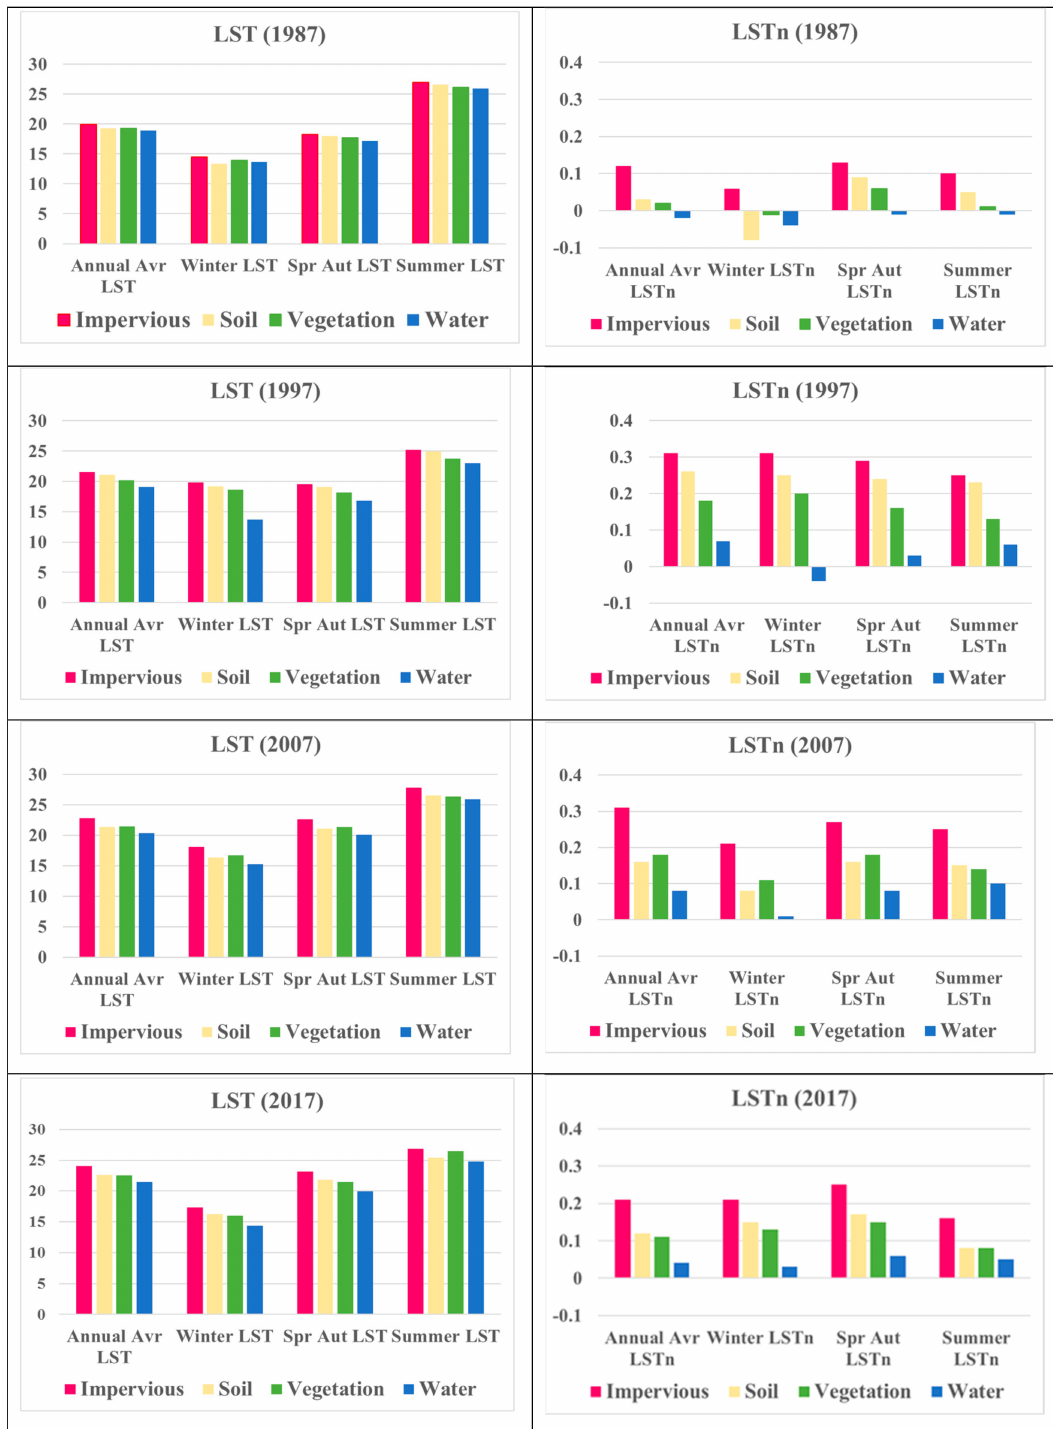
Figure 8. Variation of LST and LSTn based on land